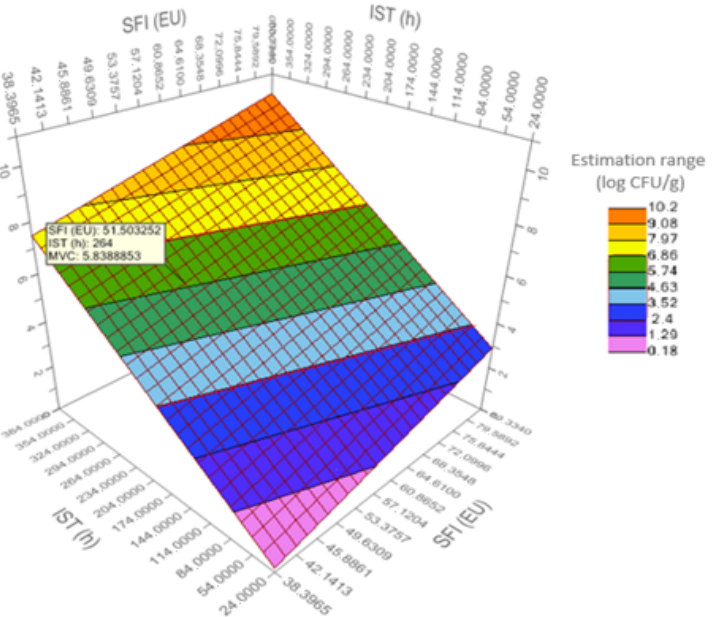
Figure 3. Response surface plot for predictive model of mesophilic viable count (log CFU/g MVC) in sea bream during iced storage. SFI (EU): sensory freshness index (%) with the European Union official method; and IST (h): ice storage time of sea bream in hours.